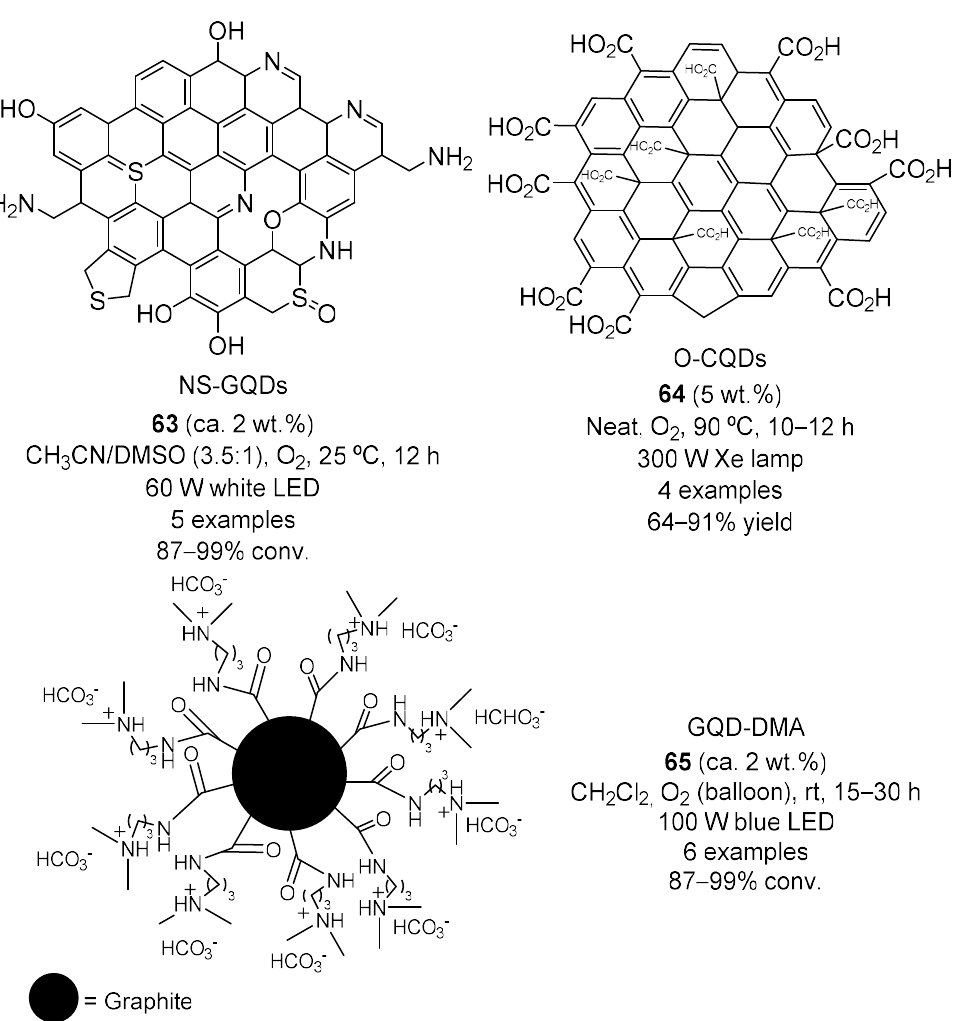
Figure 17. Results obtained in the aerobic photo-oxidative coupling of benzylamines to N -benzylidene benzylamines 2 catalyzed by 63 – 65 .